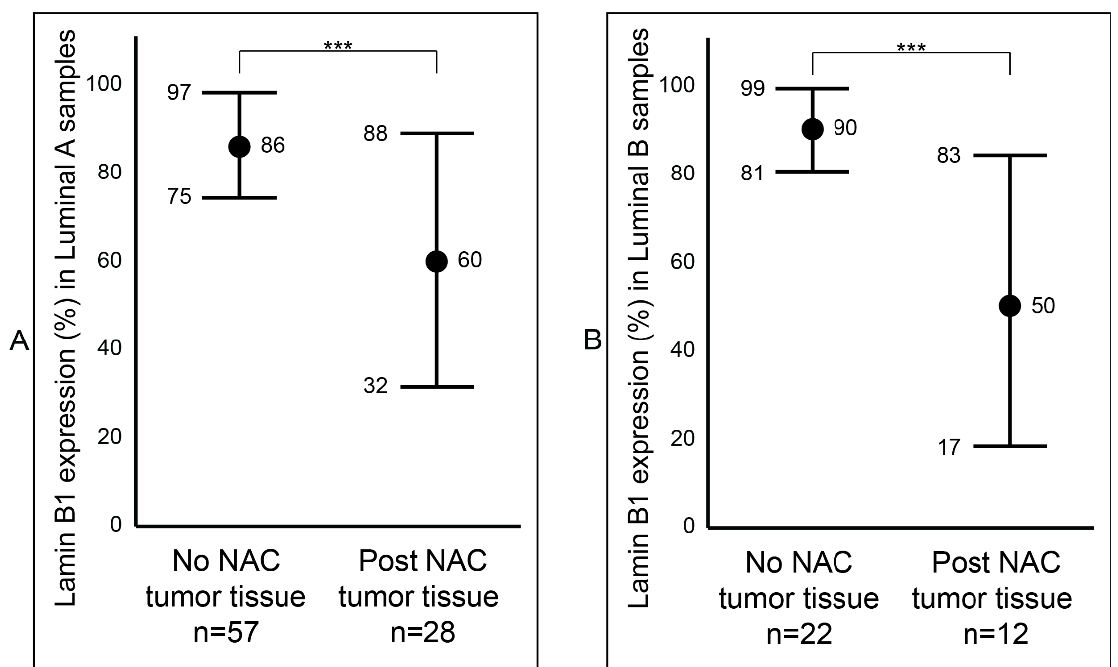
Figure 4. Comparison of lamin B1 protein expression between not exposed to NAC and post- NAC invasive breast carcinoma according to the molecular subtyping. ( A ) In luminal A samples. ( B ) In luminal B samples. Error bars show mean and ± 1 SD. Statistical differences were calculated using the Mann-Whitney test. ***: p value < 0.001.